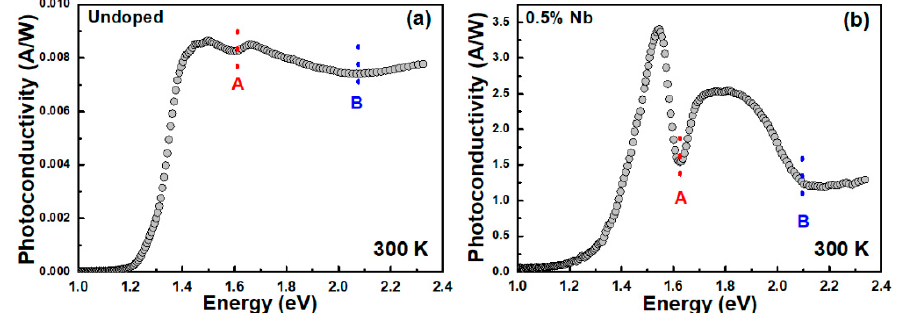
Figure 2. The photoconductivity (PC) spectra of ( a ) undoped and ( b ) 0.5% Nb-doped WSe 2 -layered crystals at 300 K. The excitonic transitions A and B are indicated by arrows. Table 1. Comparison of photoresponsivity for the WSe 2 and MoS 2 based photodetection devices. Structure